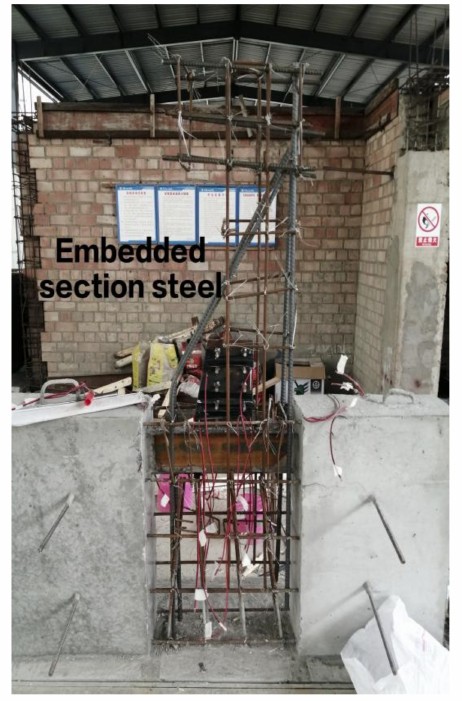
Figure 8. Frame of the coupling beam.